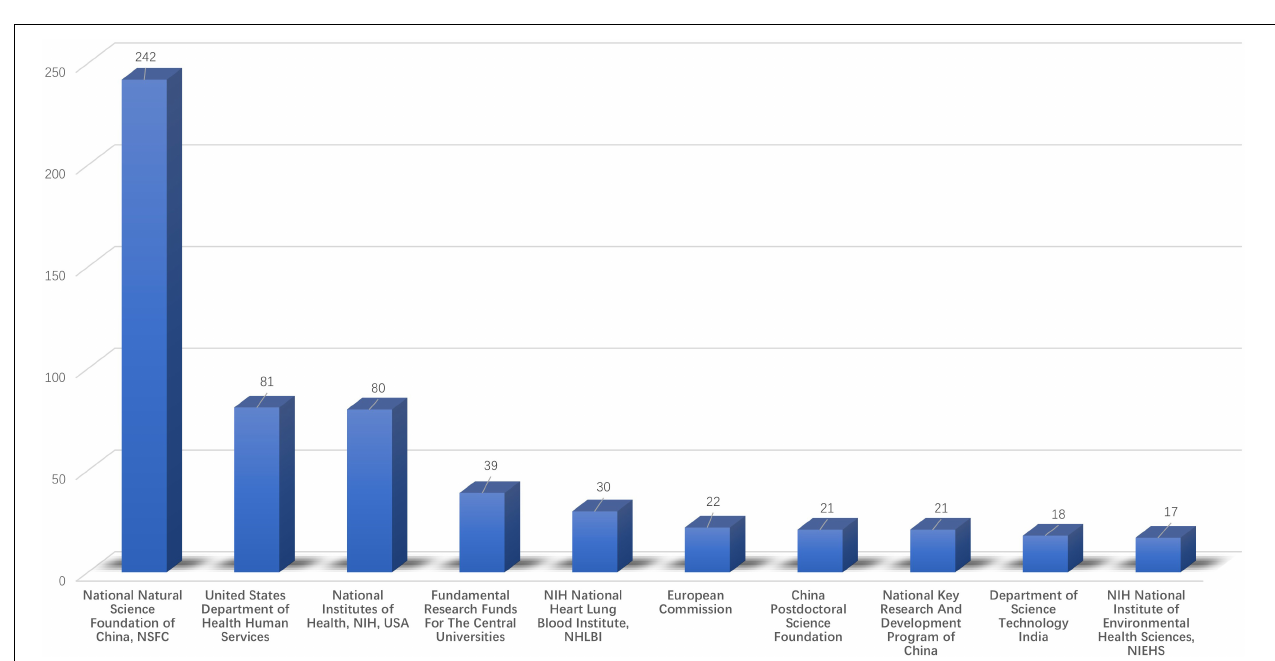
FIGURE 3 | The most contributing institutes in the field of ROS based nanotechnology for cardiovascular diseases.